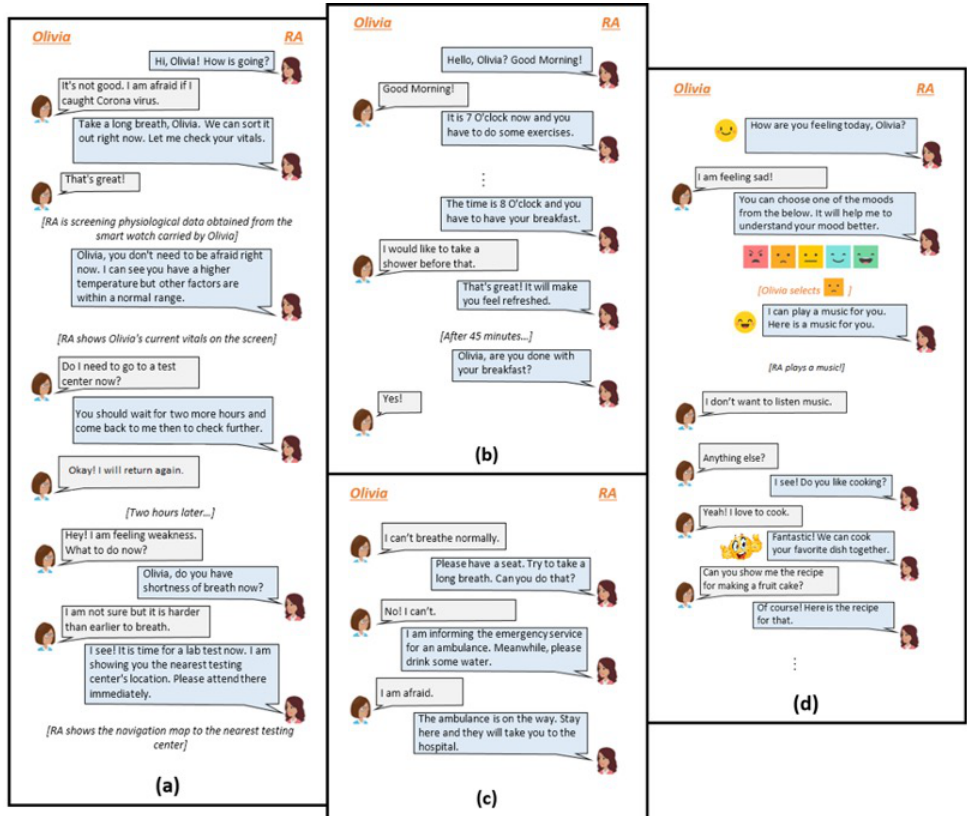
Figure 1. Snippets of designed conversations where the interaction between Olivia and the RA regarding ( a ) guidance for COVID-19 testing when Oli is suspecting infection; ( b ) practicing healthy behaviors for fast recovery when Oli is isolating at home; ( c ) handling an emergency during Oli home isolation; ( d ) managing anxieties during the post-recovery